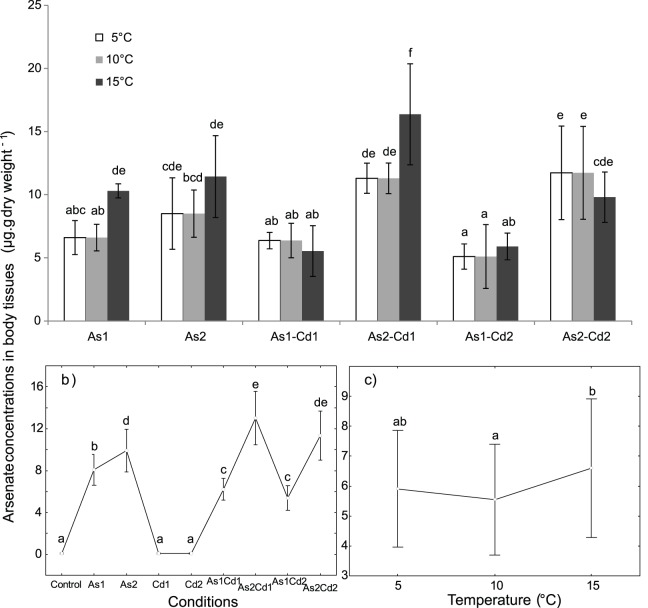
Mean arsenate concentrations in G. pulex body tissues (µg. g dry weight−1).Concentrations obtained for individuals exposed 96 h to different conditions (control, arsenate, cadmium and four binary mixtures) at three temperatures (5-10-15°C). a) Temperature × condition effect: Mean internal arsenate concentration in G. pulex for each tested condition and temperature. Vertical bars represent standard deviations. b) Condition effect: Weighted mean concentration of internal arsenate for each tested condition (results for all the tested temperatures were combined). Vertical bars represent 0.95 confidence intervals. c) Temperature effect: Weighted mean concentration of internal arsenate concentrations for each temperature (results for all the tested conditions were combined). Vertical bars represent 0.95 confidence intervals. Letters (a to f) were used as labels to illustrate significant differences in mean [AsV] values (two-way ANOVAs + LSD Fisher post hoc tests; at p<0.05 level of significance).